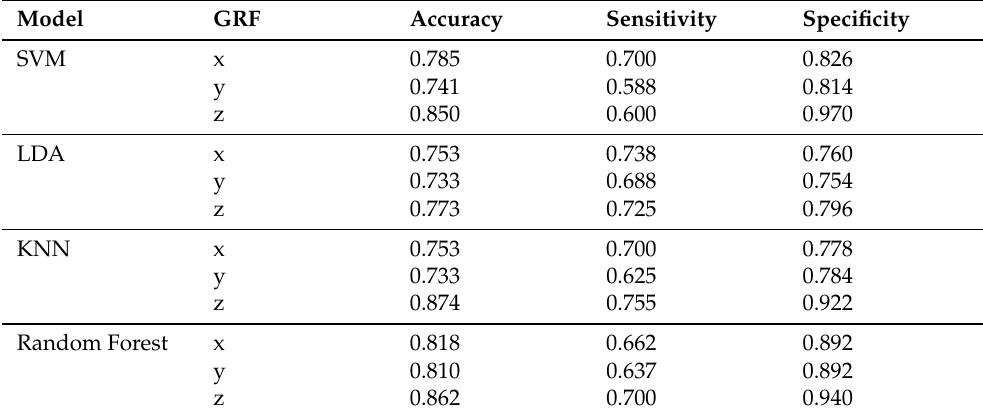
Table 2. Human subject classification results through machine